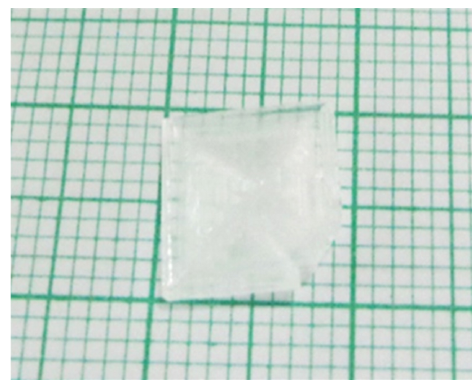
Figure 1. Photograph of as-grown LCHB crystal.